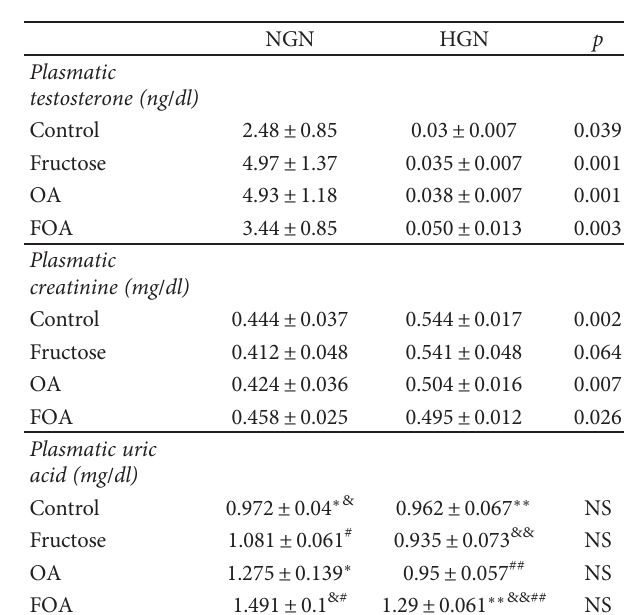
Table 3: Biochemical